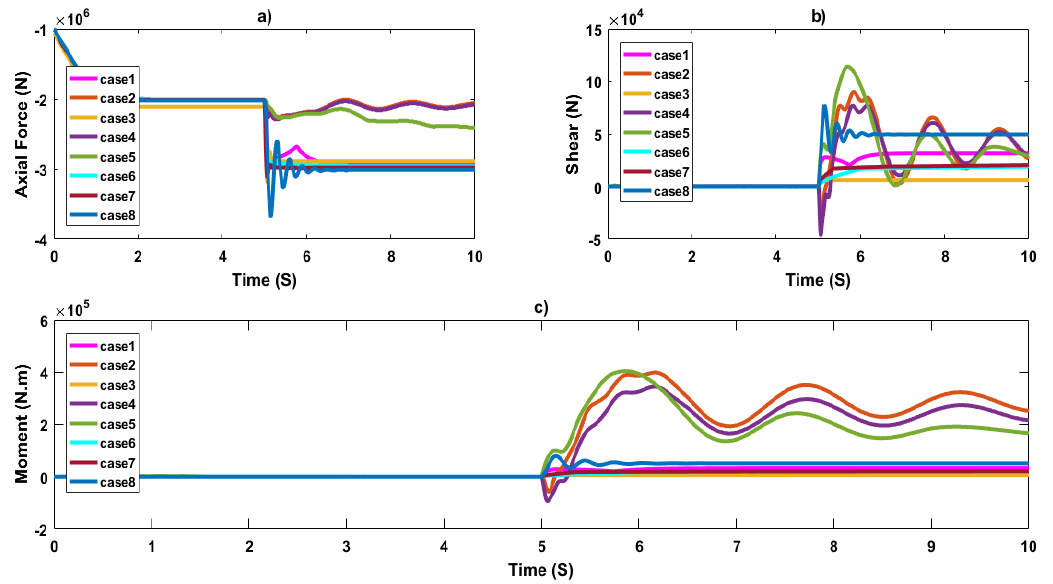
Figure 21. Column behavior after column removal in story one: ( a ) axial force, ( b ) shear, and ( c ) moment. Table 6. Result force story 1 for element 53. Table 7. Result force story 6 for element 58.